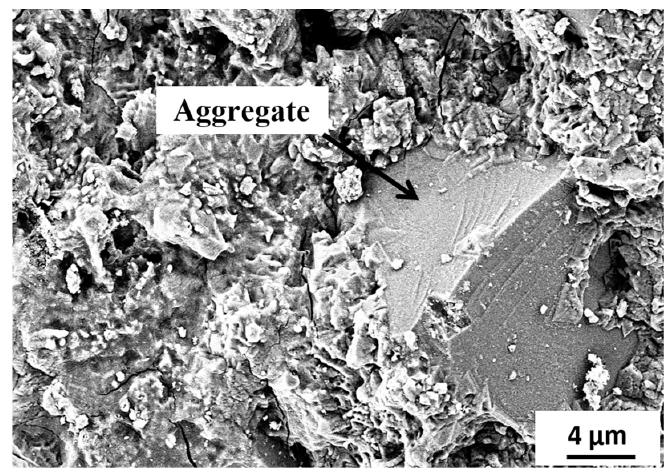
Figure 15. SEM images of specimens incorporating Orakzai source aggregates.